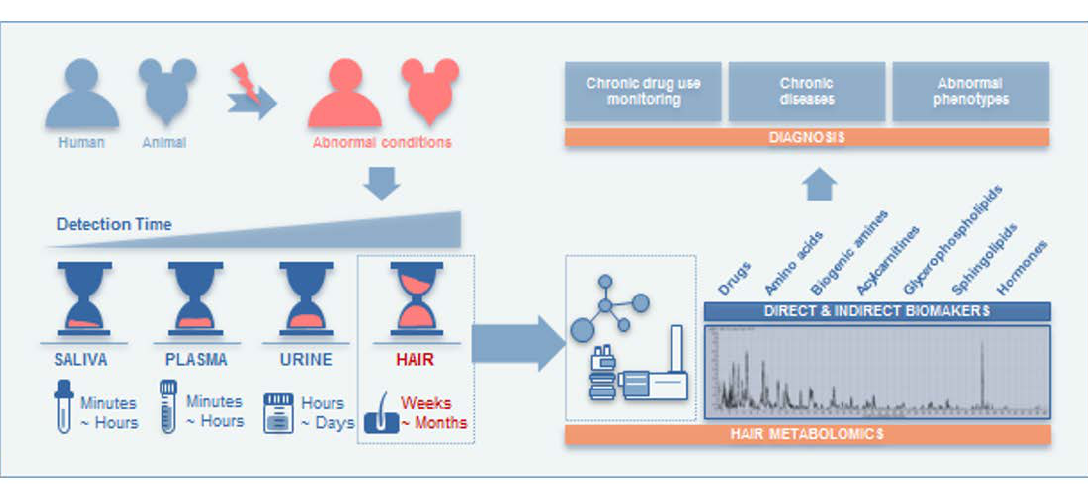
Figure 3. Application of hair